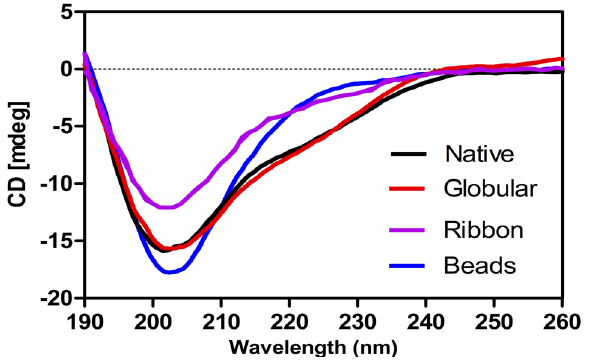
Figure 9. Circular dichroism (CD) spectra of native α -CTx TxIA and its